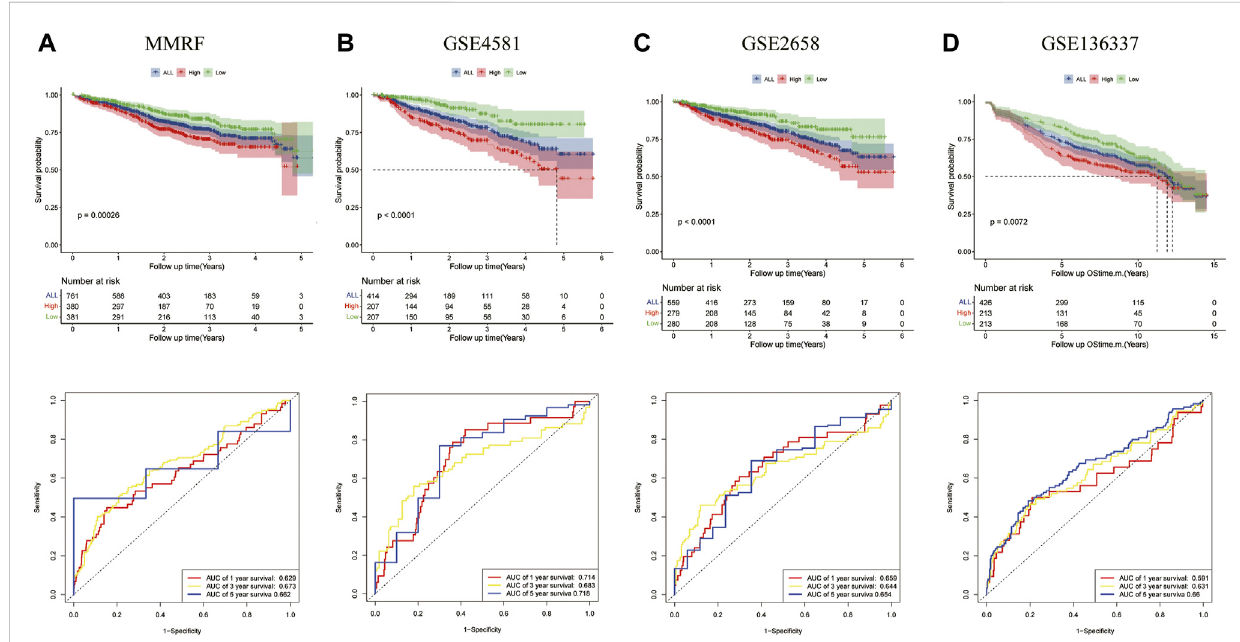
FIGURE 5 Validationoftheeight-generiskscore modelinthetestingdatasets. (A) TheKaplan – MeierOScurvesforpatientsinthehigh-andlow-riskgroupsin the MMRF cohort ( p = 0.00026, top). ROC curves showed the prognostic performance of the prognostic model in the MMRF cohort. (bottom) (B) OS in GSE4581 ( p < 0.0001, top), ROC curve in GSE4581 (bottom). (C) OS in GSE2658 ( p < 0.0001, top), ROC curve in GSE4581 (bottom). (D) OS in GSE136337 ( p = 0.0072, top), ROC curve in GSE136337 (bottom).